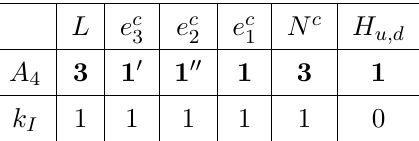
Table 1 . The Feruglio model of leptons, where each supermultiplet has a modular weight (cid:0) k I